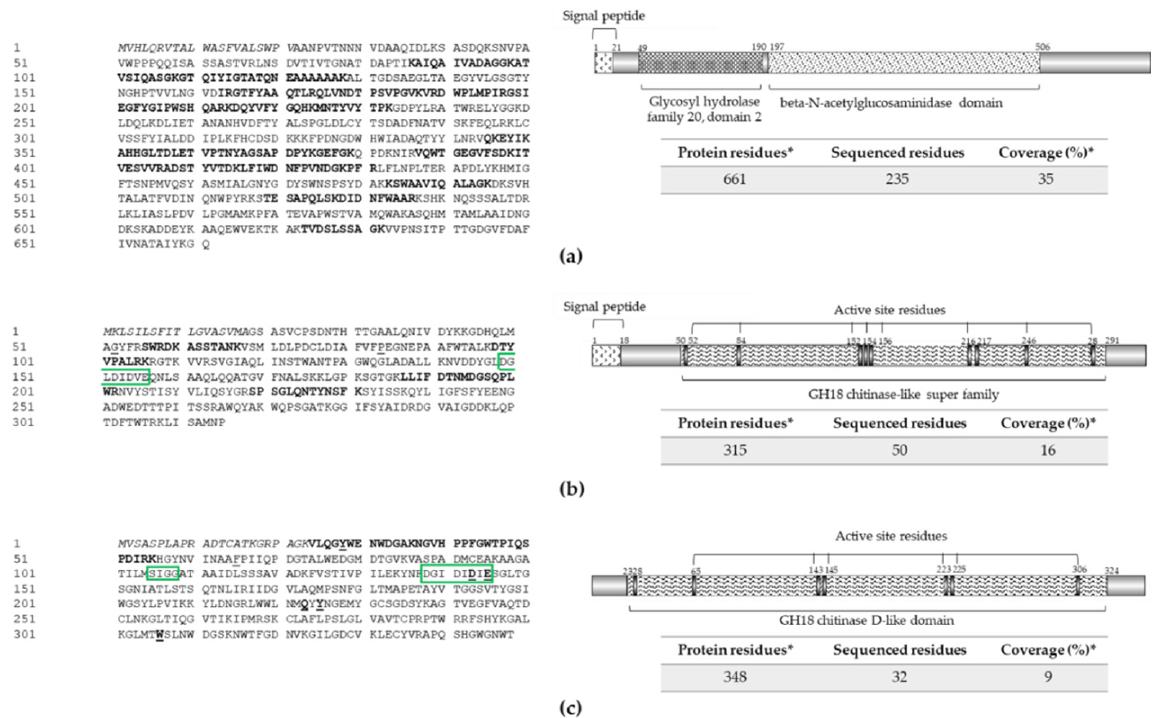
Figure 4. Extracellular chitinases identified in protein extract from strain RGM 2184 culture super- natant in A8 and/or M2 media. ( a – c ) Sequences and scheme of exochitinases Chi1 (OP328430), Chi2 (OP328427), and Chi3 (OP328428), respectively. Exochitinase sequences (left panel) were predicted from the B. pseudobassiana RGM 2184 genome (JAKJXD000000000.1). Peptides sequenced by mass spectrometry are highlighted in bold (left panel). Relevant domains for these proteins (right panels) were detected though the NCBI conserved domains database. Signal peptide (italic), active site residues (underlined), and relevant motives (green rectangle) are represented in left and right panels, respectively. * indicate predicted information.